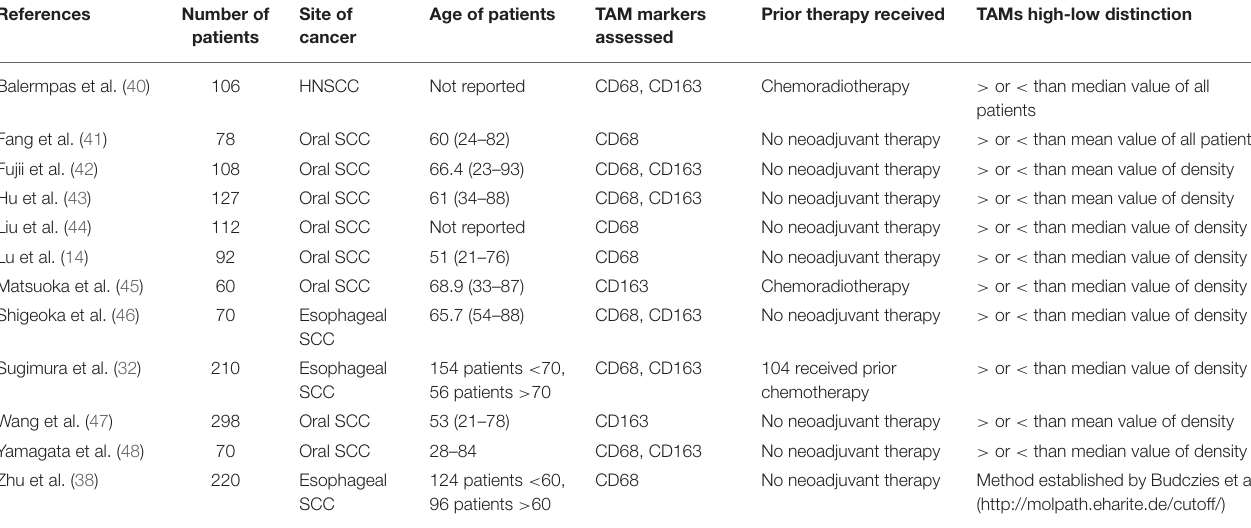
TABLE 1 | Characteristics of studies evaluating TAM density and clinicopathologic markers in